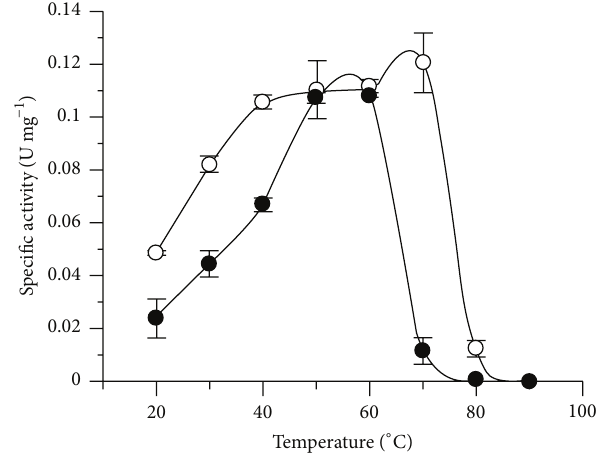
Figure 6: Effect of temperature on PeiW ( I ) and PeiP ( e ) using a synthetic peptide